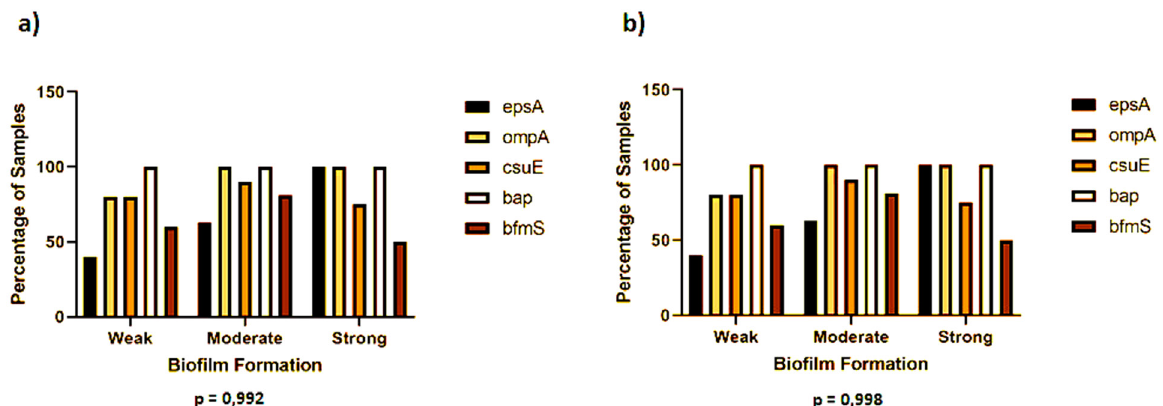
Figure 4. Comparison between biofilm formation and frequency of virulence genes in Acinetobacter spp. isolates in Recife – PE – Brazil. a) Infection isolates and b) Colonization